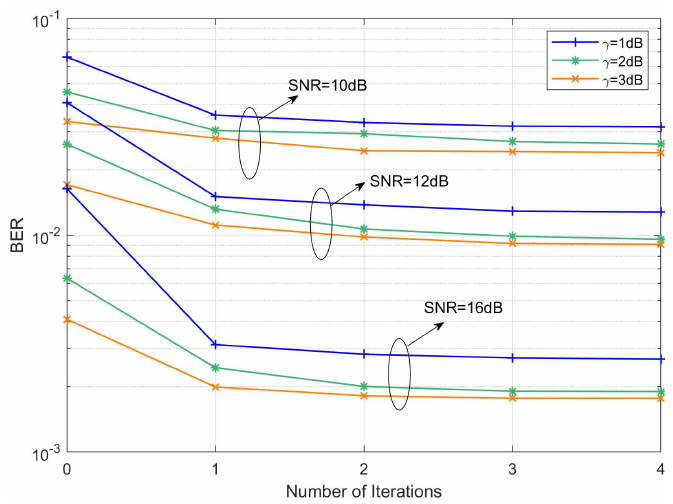
Figure 8. BER convergence of a clipped OTFS-BFDM system with RRC PWFs under different iterations ( α =